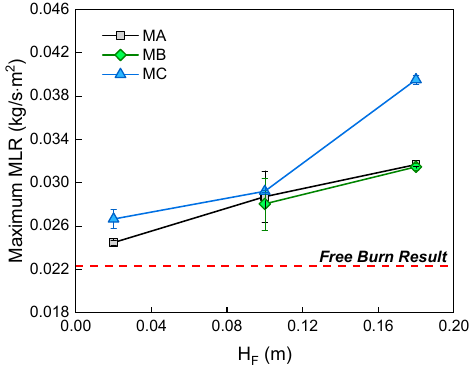
Figure 21. Mass loss rates for heptane fuel in all model-scale tests.